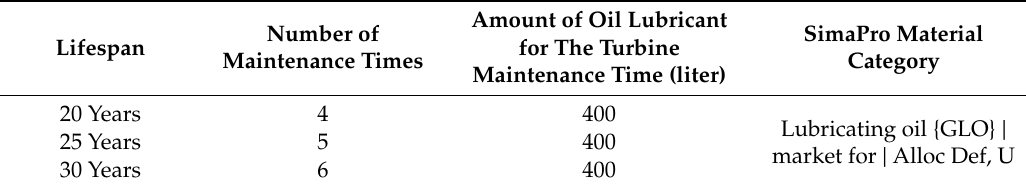
Table 5. Quantity of lubricant needed for the maintenance and operation